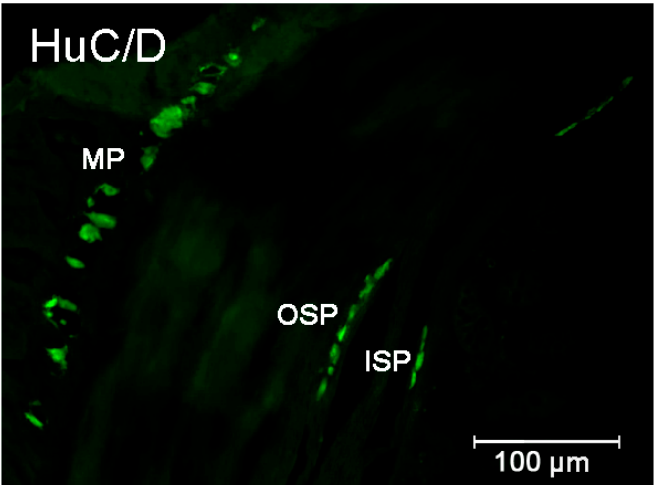
Figure 1. Organization of the enteric neurons in the pig intestine wall demonstrated by the labeling with Hu C/D—used as a pan neuronal marker. Elements of the enteric nervous system: MP—myenteric plexus; OSP—intestinal outer submucosal plexus; ISP—intestinal inner submucosal plexus.